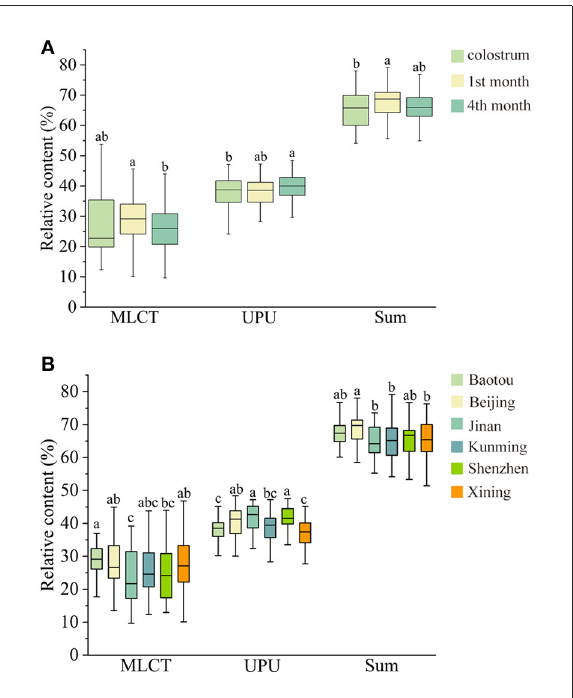
FIGURE2 The content of MLCT, UPU, and the sum of MLCT and UPU in human milk at different lactation stages (A) and regions (B) . Different lowercase letters (a, b, c) indicate the significant differences ( P < 0.05) across lactation stages or regions.